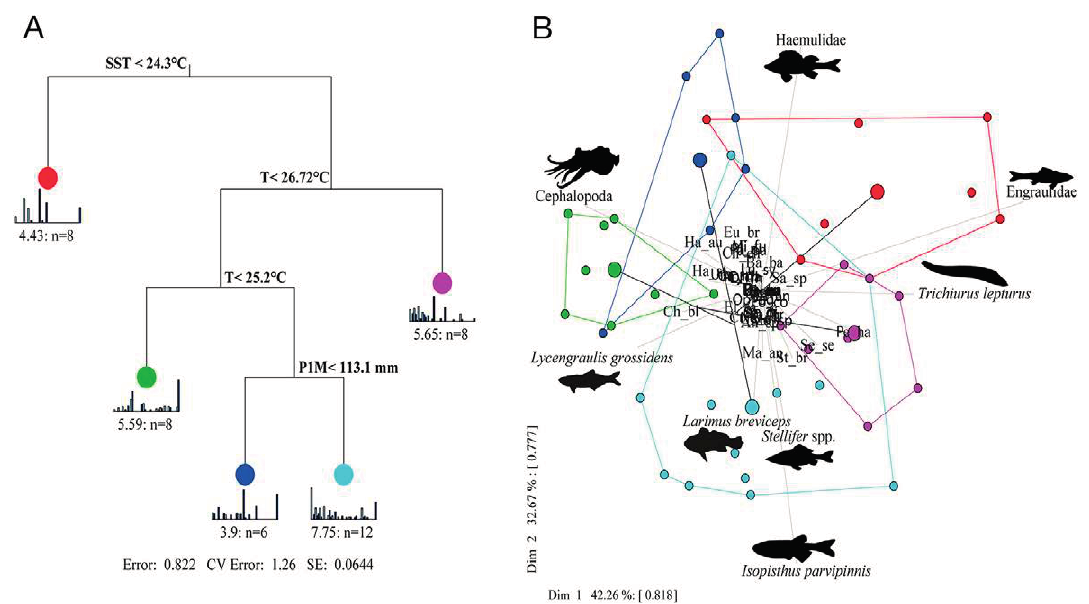
Fig. 3. – A, regression tree for responses in Guiana dolphin diet composition due to different thresholds of environmental conditions across the central Atlantic coast of Brazil. The bars below the final junctions represent changes in prey species, and height describes the probability of occurrence of each prey species in that particular environmental condition (i.e. proximity to a value of “1” and including hierarchical effects from superior groups) based on recursive partitioning of the regression tree. The order of species in the bars are in Table 2. The values below the bars represent the similarity between all sampling units within the unfolding compared with a split with the same number of observations (N). B, principal component analysis spatially ordering the sample points and their prey species occurring under certain conditions, according to the junctions formed by regression tree analysis. Species name abbreviations in Table